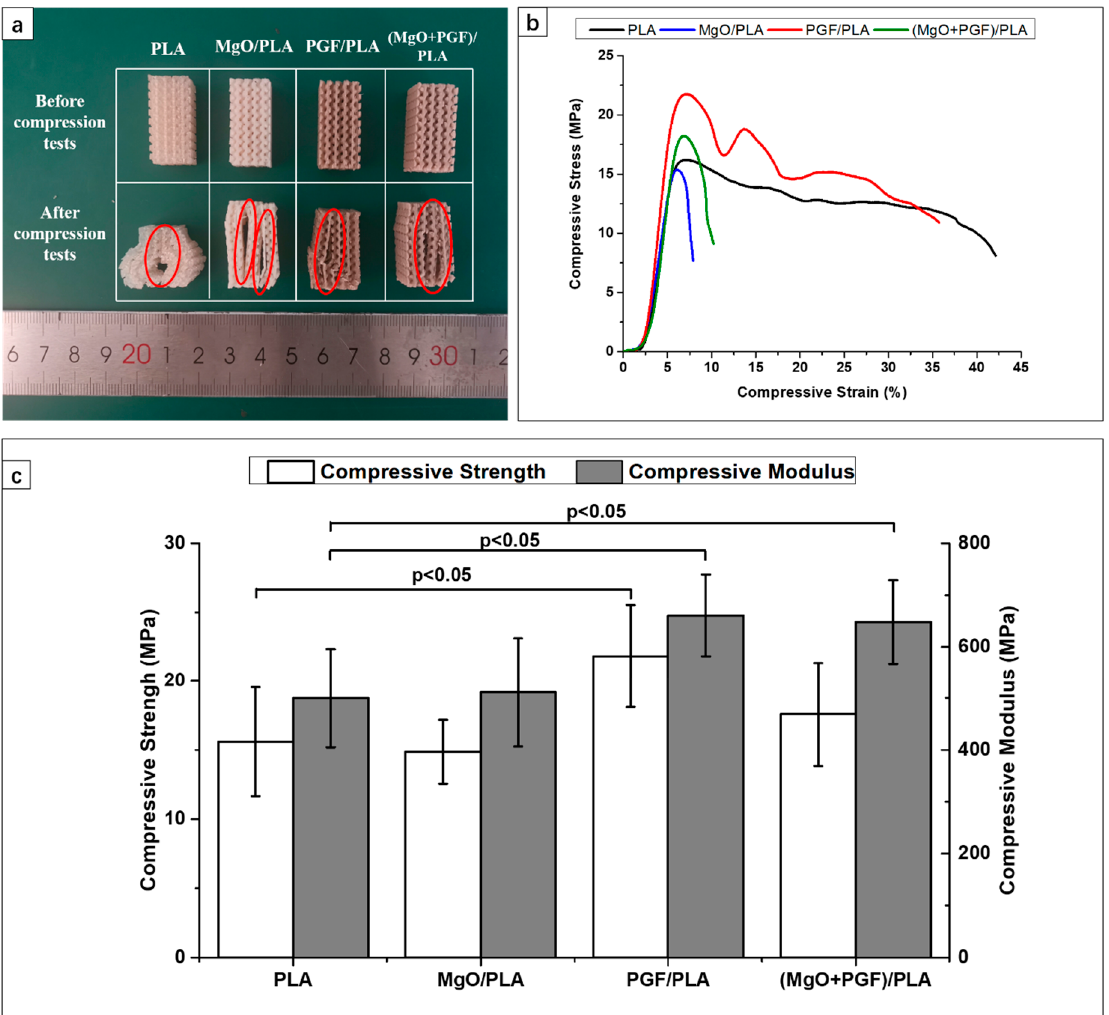
Figure 3. ( a ) Photograph of gyroid scaffolds before and after compression tests. Cracks propagated along the interlayer boundaries were highlighted with ovals; ( b ) Typical stress–strain curves of the gyroid scaffolds obtained from the compressive tests; ( c ) Summary of compressive strength and compressive modulus of the scaffold, with error bars representing the standard deviation. Five replicates were tested for each material. “ p < 0.05” indicates statistical significance as analyzed based on unpaired t -tests.